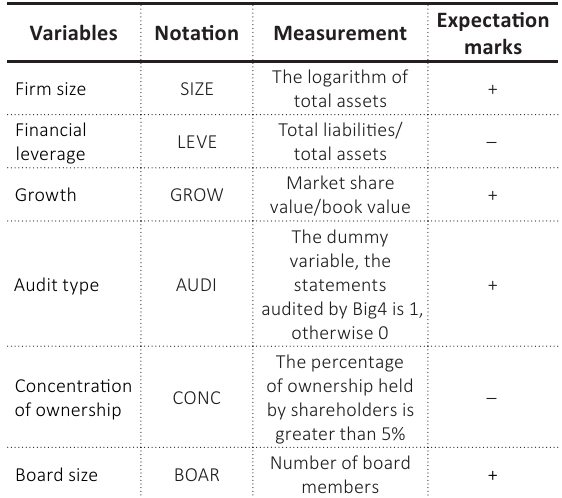
Table 1. Measurement and expectation mark